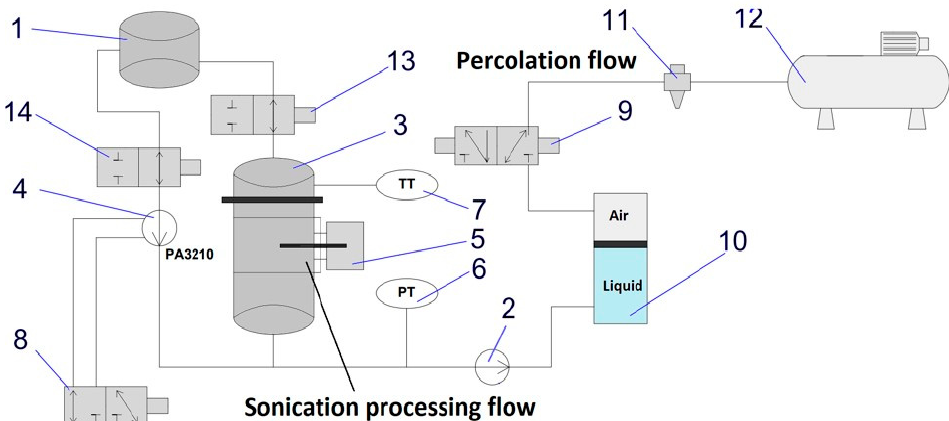
Figure 2. Functional schematic of a technology designed to produce bioactive compounds for agricultural use: ( 1 ) vessel for solvent storage, ( 2 ) firs pump, ( 3 ) extraction vessel, ( 4 ) second pump, ( 5 ) ultrasonic generator, ( 6 ) pressure sensor ( 7 ) temperature sensor, ( 8 , 9 , 13 , 14 ) solenoid valves, ( 10 ) hydro-pneumatic cylinder, ( 11 ) pneumatic distributor.